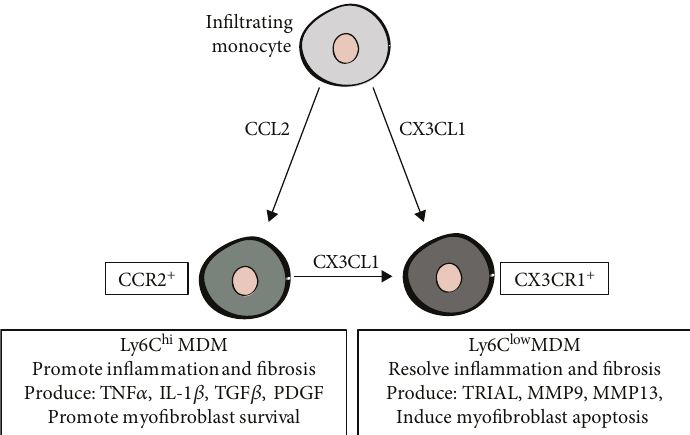
Figure 3: Di ff erential expression of Ly6C distinguishes MDMs with opposing functions in tissue repair. During liver repair, monocytes recruited by the CCL2/CCR2 axis di ff erentiate into pro fi brotic Ly6C hi -expressing MDMs. In contrast, monocytes recruited by the CX3CL1/CX3CR1 axis give rise to Ly6C low MDMs. This subpopulation promotes the resolution of tissue repair and regression of fi brosis.